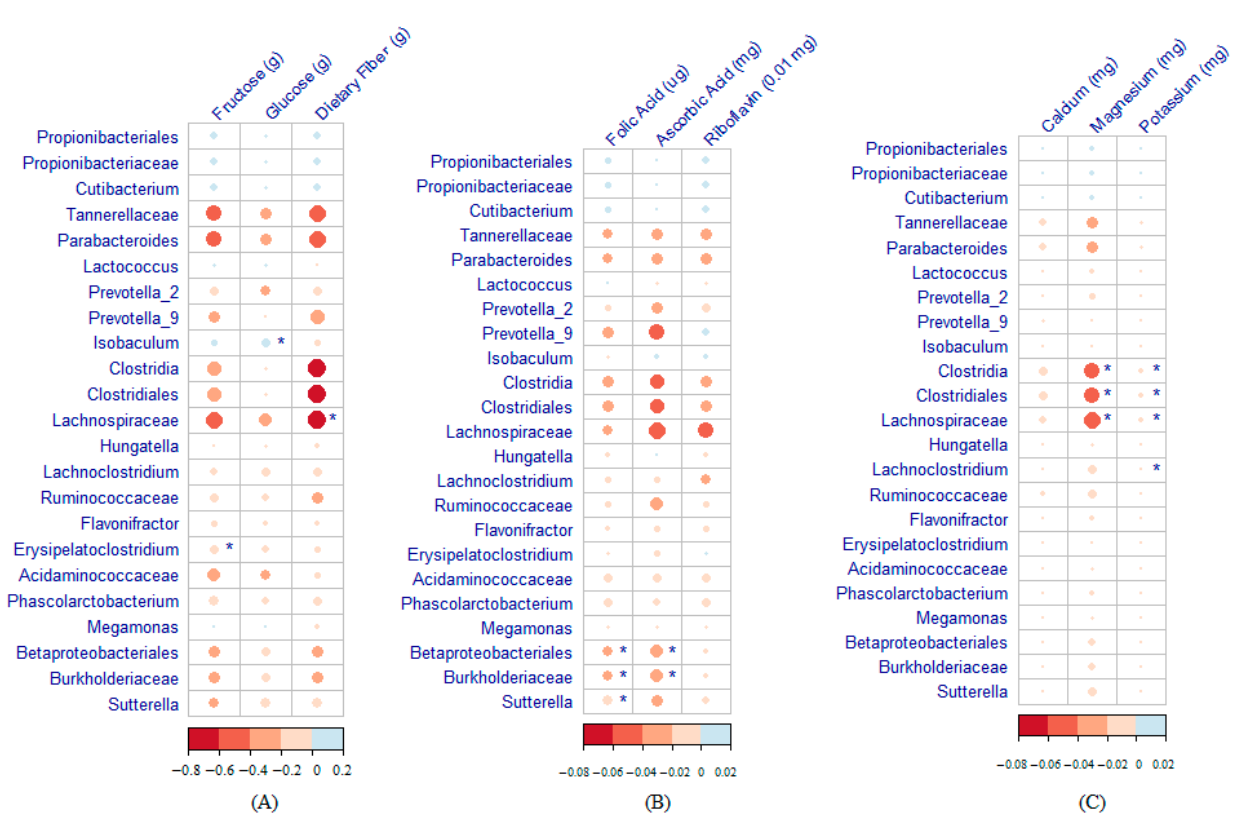
Figure 3. Heatmaps showing the correlation between maternal nutrient intake during pregnancy and the infant gut microbiome at 2 months of age (* Significant association). ( A ) Macronutrients. ( B ) Vitamins. ( C ) Minerals.